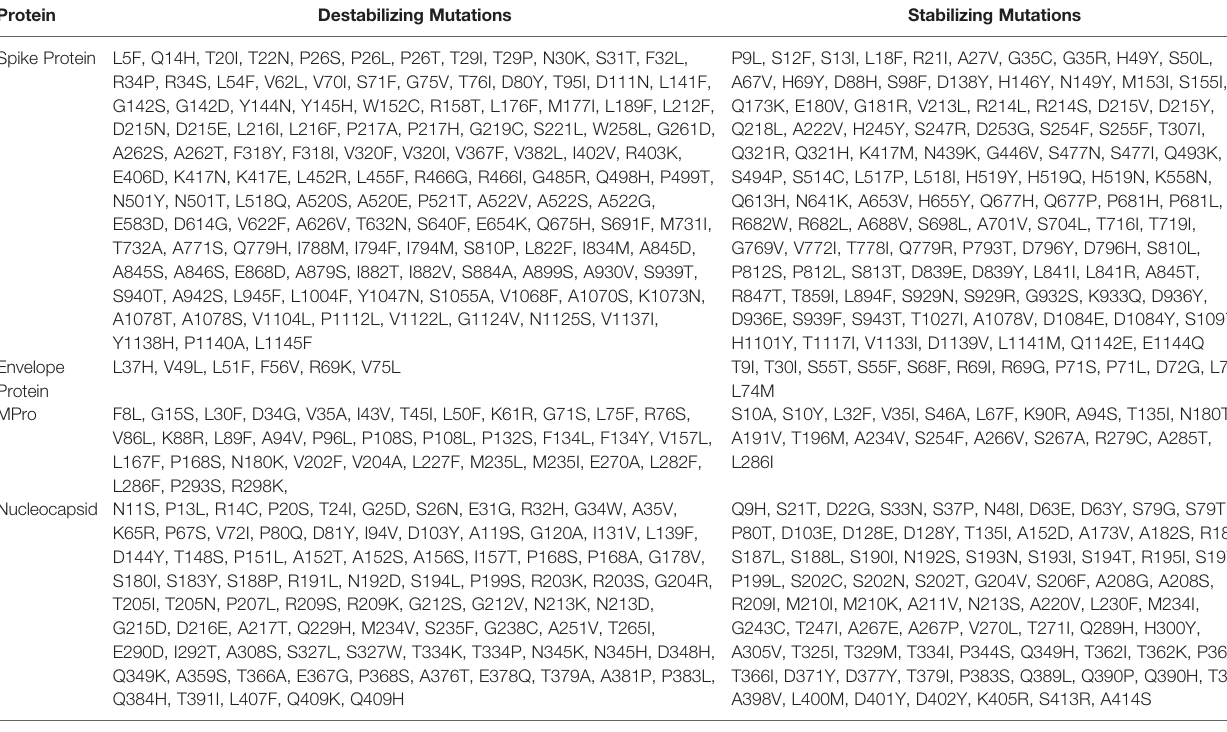
TABLE 1 | Selected mutations predicted to be destabilizing and stabilizing through different structure-based approaches. Protein Destabilizing Mutations Stabilizing